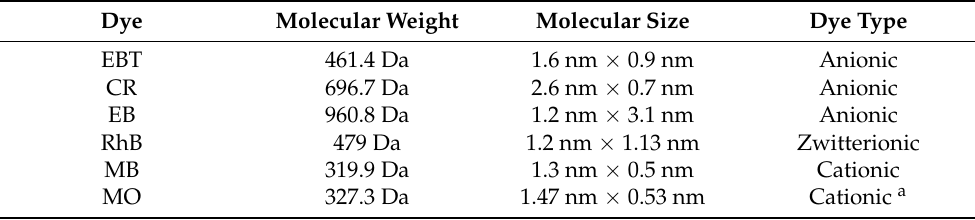
Table 1. Molecular information of the experimental dyes. Dye Molecular Weight Molecular